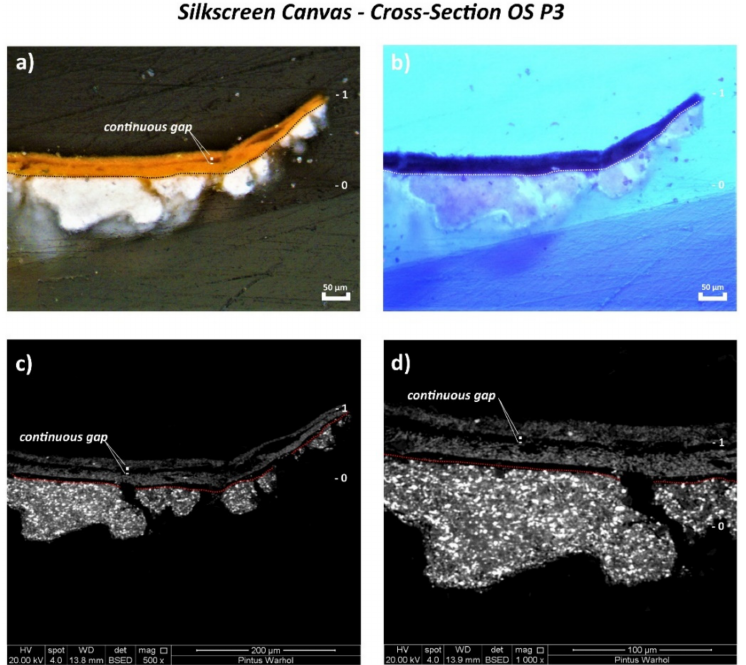
Figure 8. ( a ) Optical microscopy image of the cross-sectioned OS P3 sample under reflected visible light (Vis) showing the main layers and ( b ) under ultraviolet light (UV). ( c ) SEM micrograph of the whole cross-sectioned OS P3 sample and ( d ) detail of the area investigated by bulk area EDX analyses showing the main paint layers.